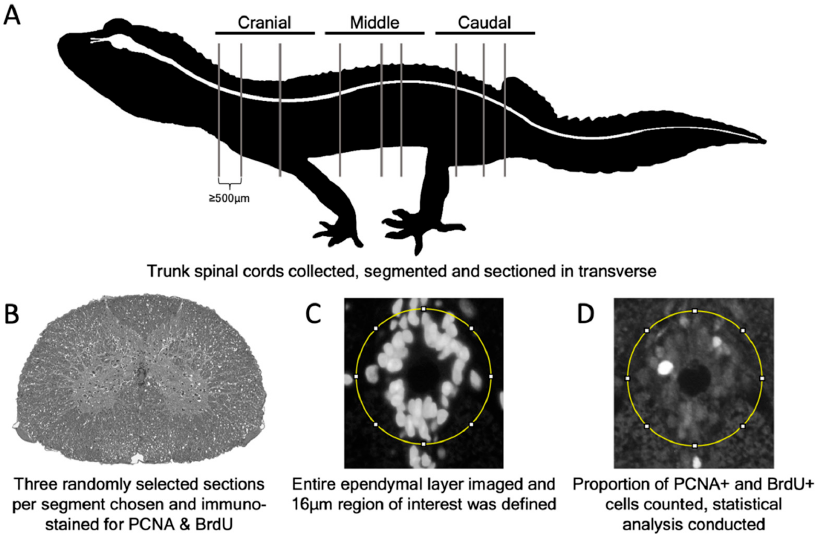
Figure 1. Experimental design. ( A ) Schematic representation of the leopard gecko ( Eublepharis macularius ) in lateral view. The central nervous system is highlighted in white. Trunk spinal cords ( n = 3 per group) were collected, divided into three equal segments (cranial, middle and caudal), and sectioned in the transverse plane. ( B ) Three random sections, 500 to 2500 µm apart, were selected and immunostained for either PCNA or BrdU. ( C ) The entire ependymal layer was then imaged. To define the region of interest, a 16 µm diameter circle was drawn around the ependymal layer, orig- inating from the center of the central canal. ( D ) The proportion of PCNA+ or BrdU+ cells across each group was collected using ImageJ and statistically analyzed.